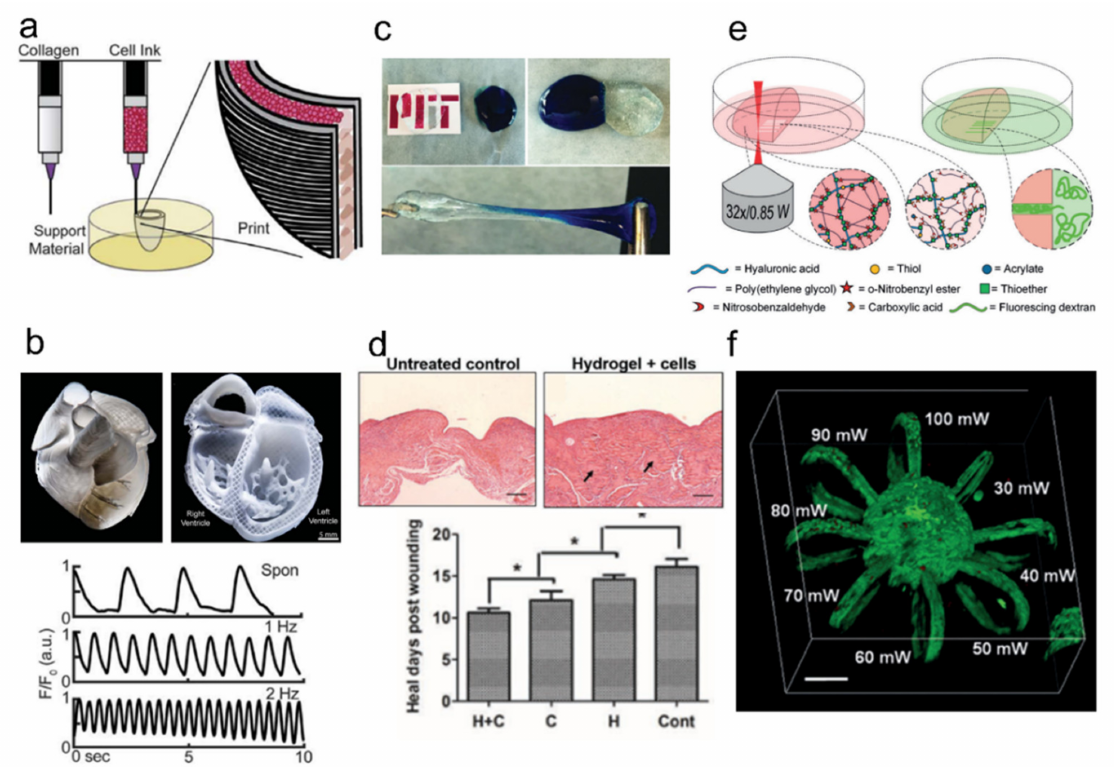
Figure 9. Mammalian cell-laden hydrogels for tissue engineering. ( a , b ) Collagen-based human heart 3D printing. ( b ) Demonstration of 3D-printed contracting ventricle and neonatal human heart